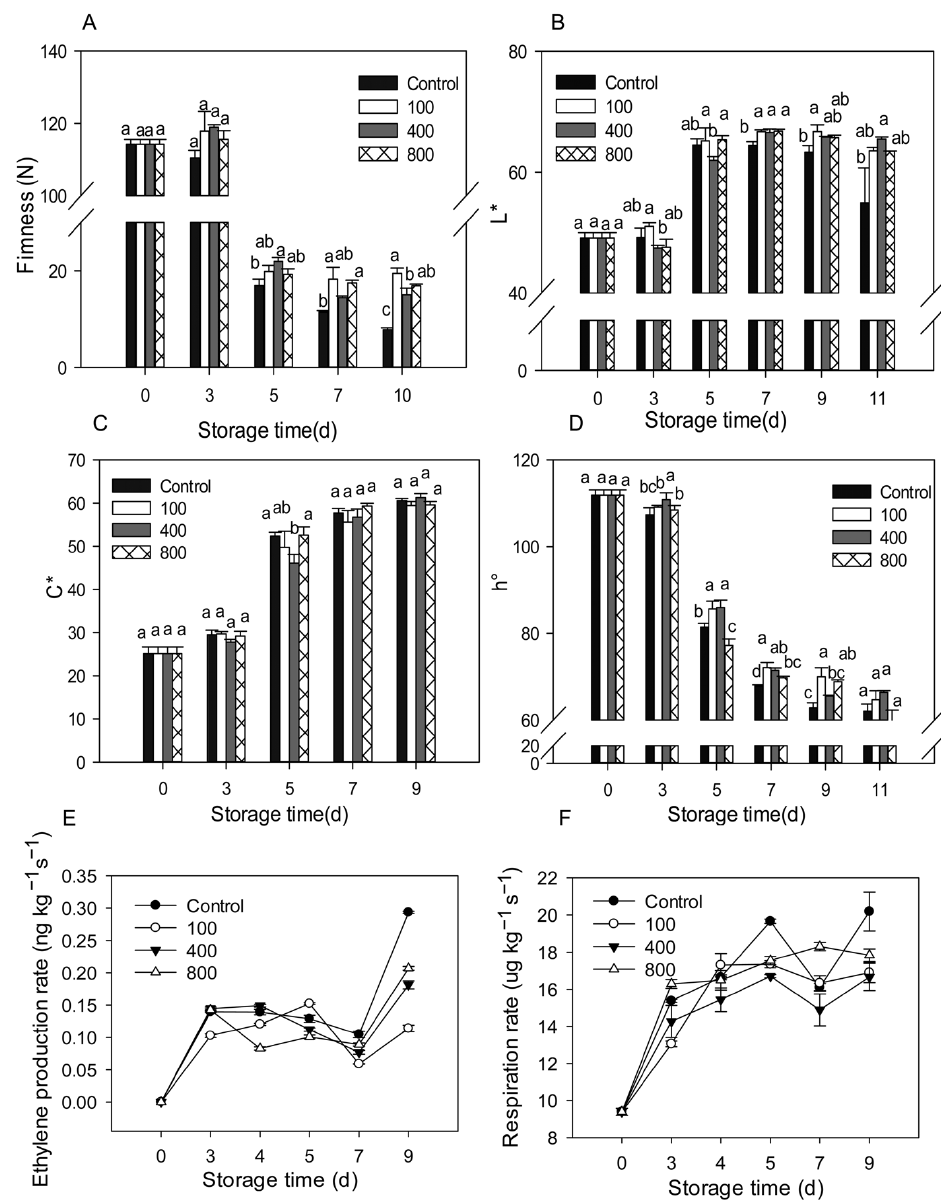
Figure 1. Effects of melatonin applications on fruit physiology. ( A ) Impact of melatonin treatments on papaya fruit firmness. ( B , C ) The effect of melatonin treatment on the chromaticity L* ( B ), C* ( C ), h° ( D ) of papaya fruit. ( E ) The effect of melatonin treatment on ethylene production rate in papaya fruits. ( F ) The effect of melatonin treatment on the respiration rate in papaya fruits. Each data point indicates the mean standard deviation ( n = 3). Different letters denoted substantial changes at the 5% level. To compare significant effects at the 5% level, the least significant differences (LSDs) were determined. “100”, “400” and “800” indicated the “100 μmolL − 1 ”, “400 μmolL − 1 ” and “800 μmolL − 1 ” melatonin